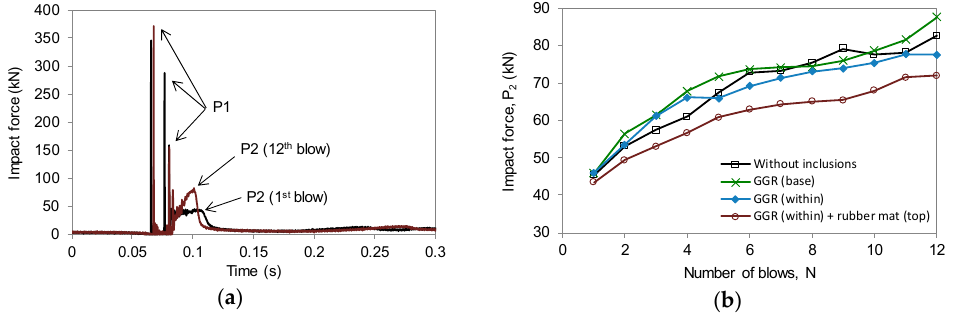
Figure 8. ( a ) Impact force-time histories recorded in the first and last blows of test T1 (unreinforced sample); ( b ) Variation of impact force P 2 with number of blows.